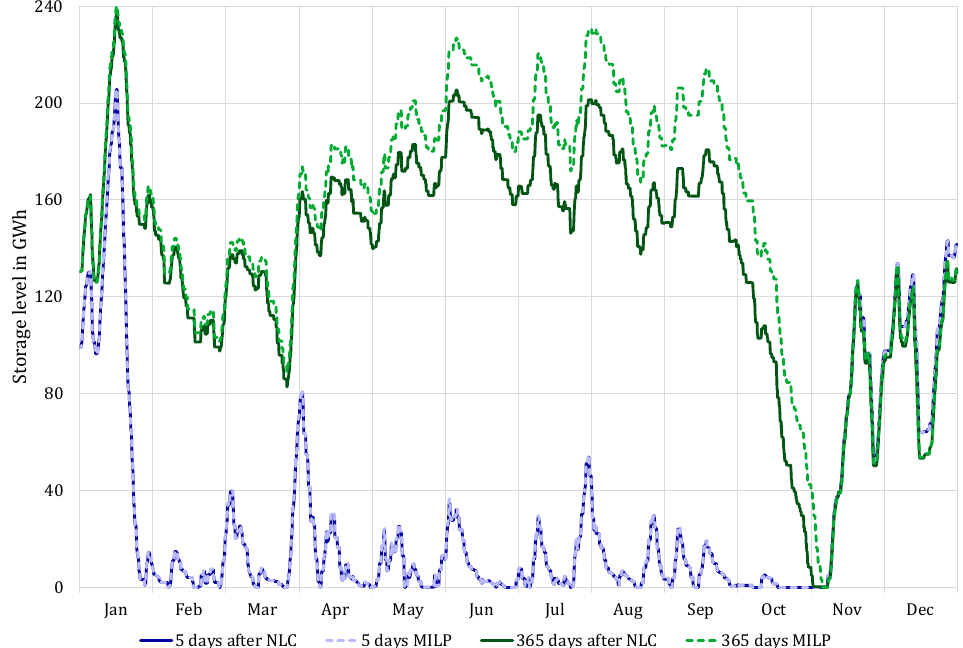
Figure 10. Time series of the storage level of a long-term storage for MILP result (dashed) and after control calculation (solid) for 3000 MW each VRE power, using 5 days interval (scenario c, blue) and 365 days interval (scenario f, green).